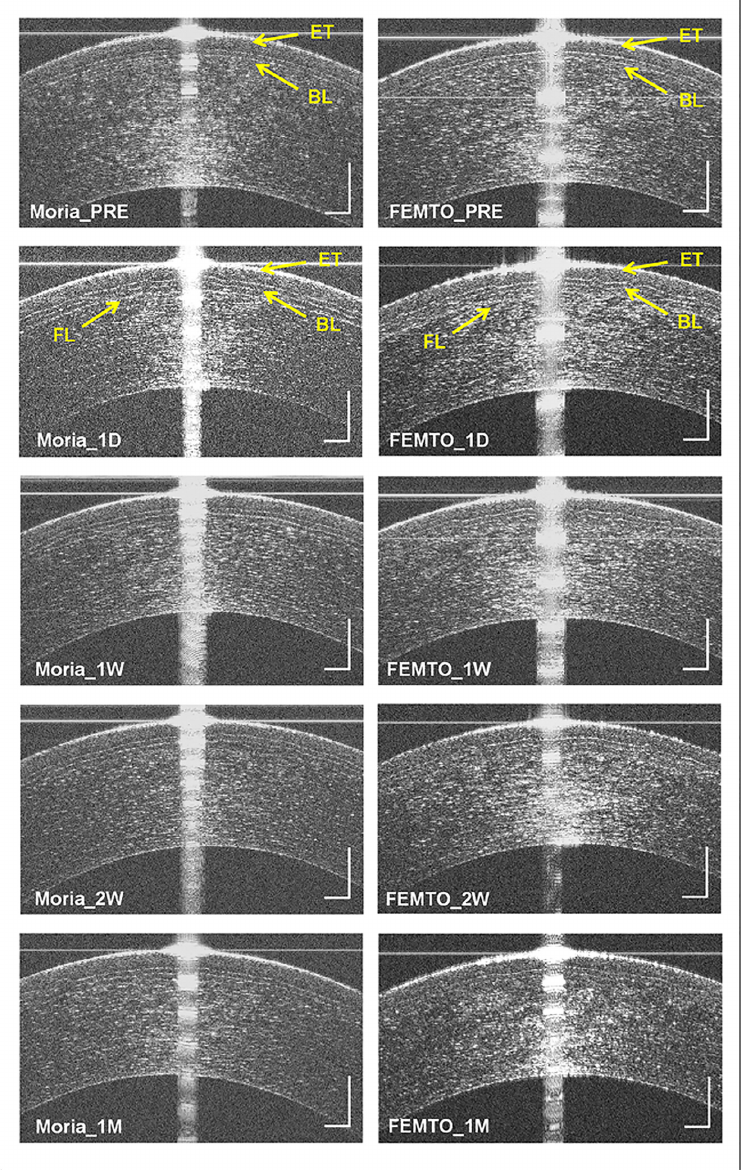
Fig 3. UHR-OCT images taken before and after sub-Bowman 0 s keratomileusis (SBK) surgery in the Moria and FEMTO groups. (A) UHR-OCT image before Moria SBK. (B) UHR-OCT image of 1 day post Moria SBK. (C) UHR-OCT image of 1 week post Moria SBK. (D) UHR-OCT image of 2 weeks post Moria SBK. (E) UHR-OCT image of 1 month post Moria SBK. (F) UHR-OCT image before FEMTO SBK. (G) UHR-OCT image of 1 day post FEMTO SBK. (H) UHR-OCT image of 1 week post FEMTO SBK. (I) UHR-OCT image of 2 weeks post FEMTO SBK. (J) UHR-OCT image of 1 month post FEMTO SBK. ET, epithelium; BL, Bowman 0 s layer; FL, flap. Bars = 250 μ m.